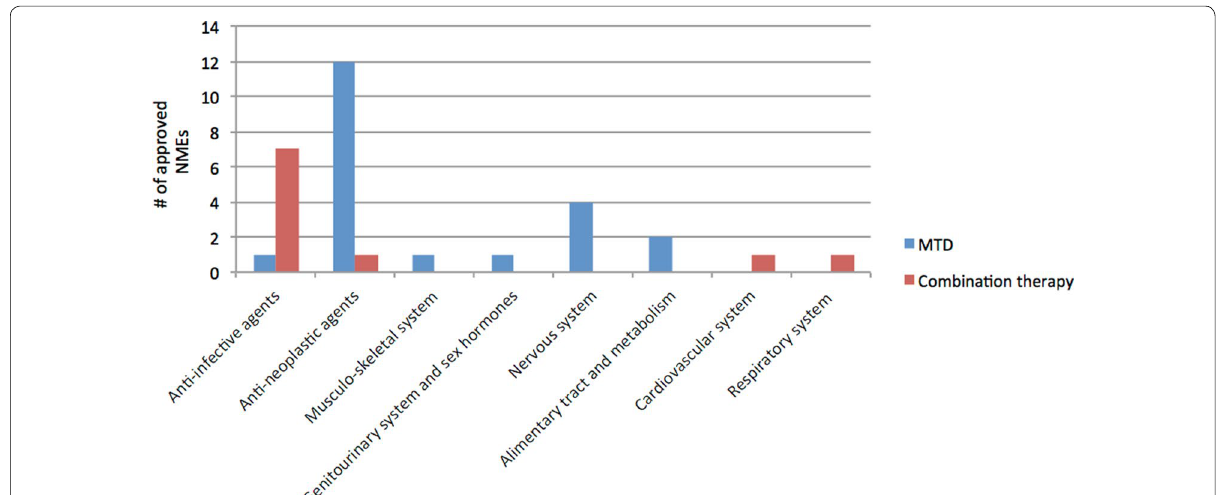
Fig. 2 The 21 multi‑target drugs and 10 therapeutic combinations approved in 2015–2017 organized according to their Anatomical Therapeutic Chemical (ATC) Classification